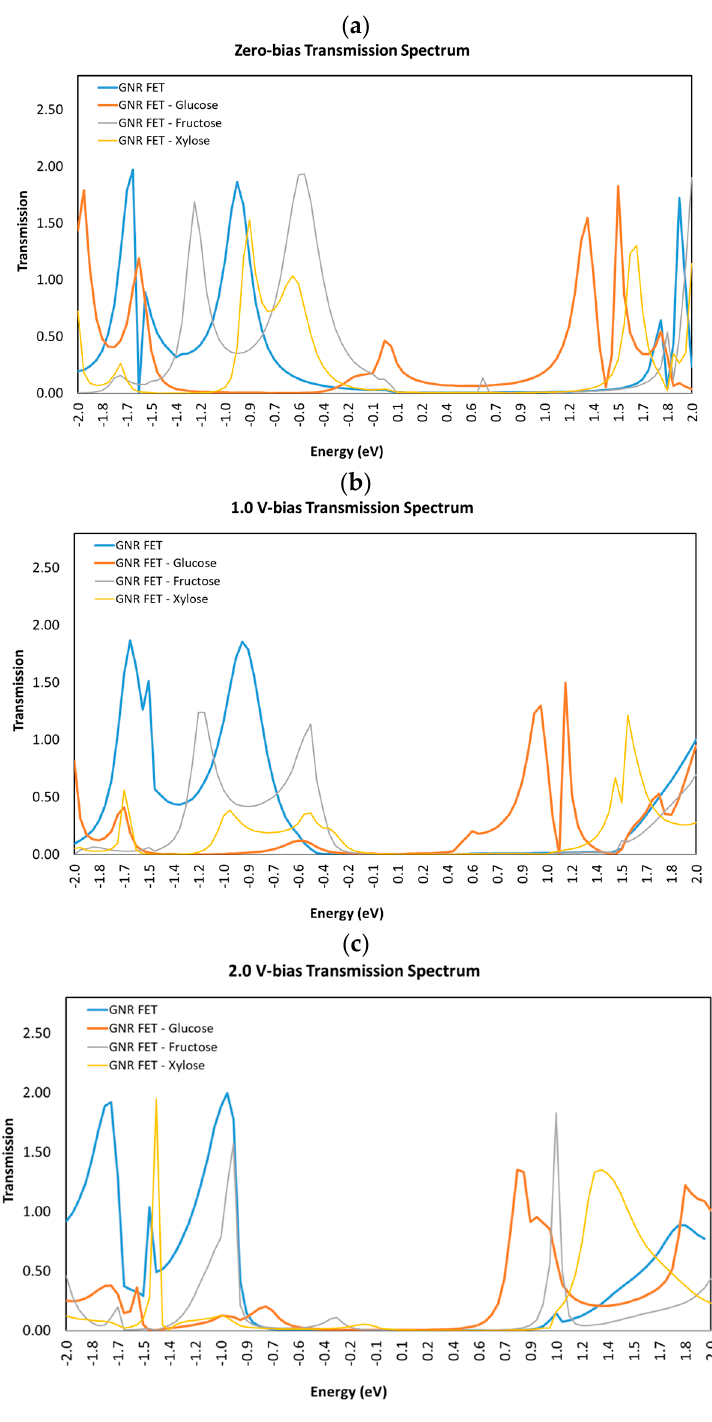
Figure 7. Transmission spectra T(E) for GNR-FET sensor without and with each of the three different sugar molecules ( a ) Bias voltage = 0 V, ( b ) Bias voltage = 1.0 V, and ( c ) Bias voltage = 2.0 V.